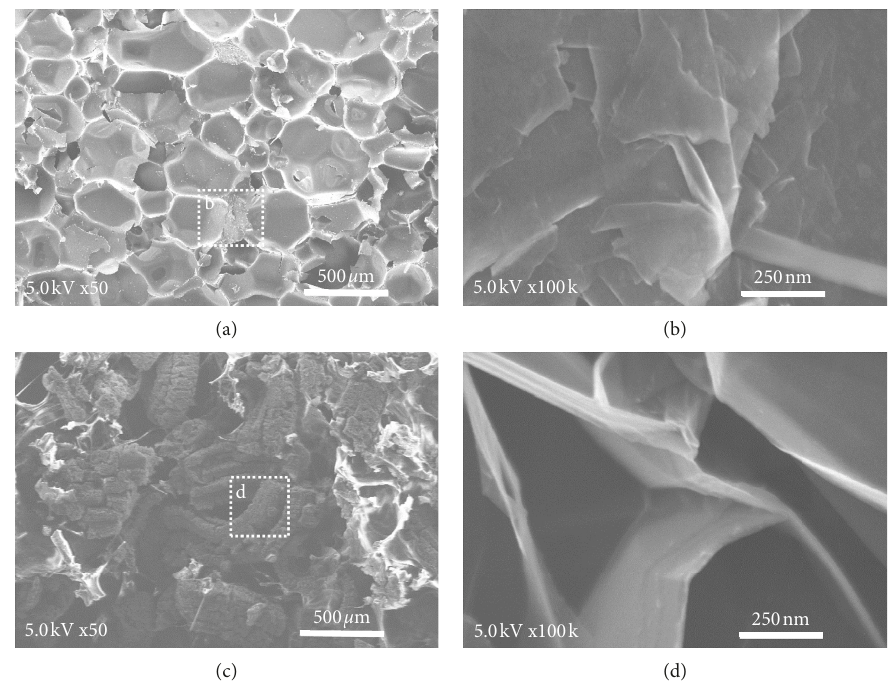
Figure 3: SEM micrographs of EG/RPUF composite before (a) and after (c) burning and their high magnification images (b) and (d), respectively.